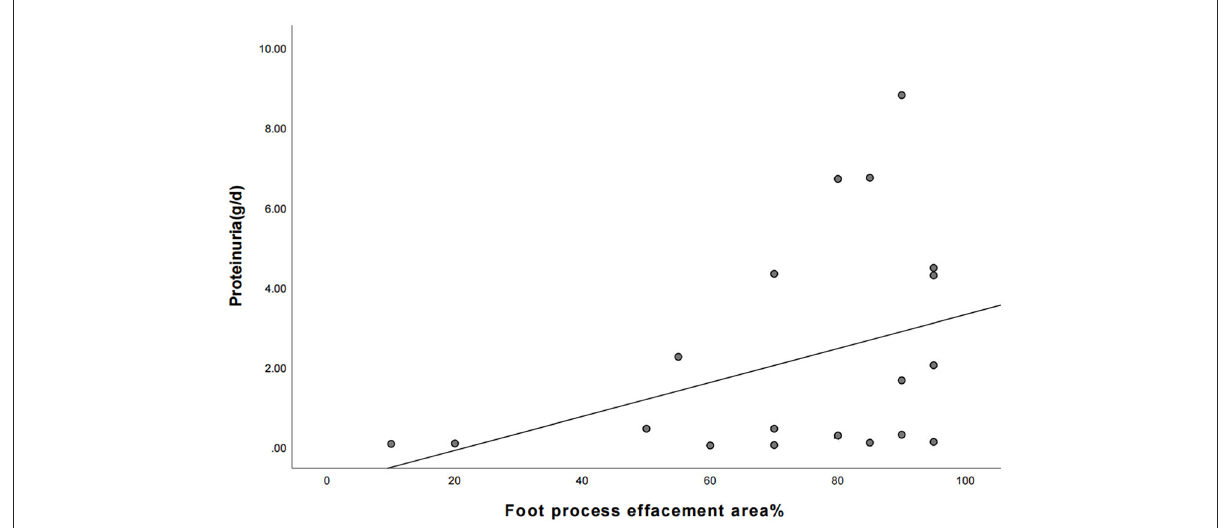
FIGURE1 The correlation between the area of foot process effacement and urine protein quantification between the two groups of children (the correlation coefficient r = 0.435, P = 0.055).